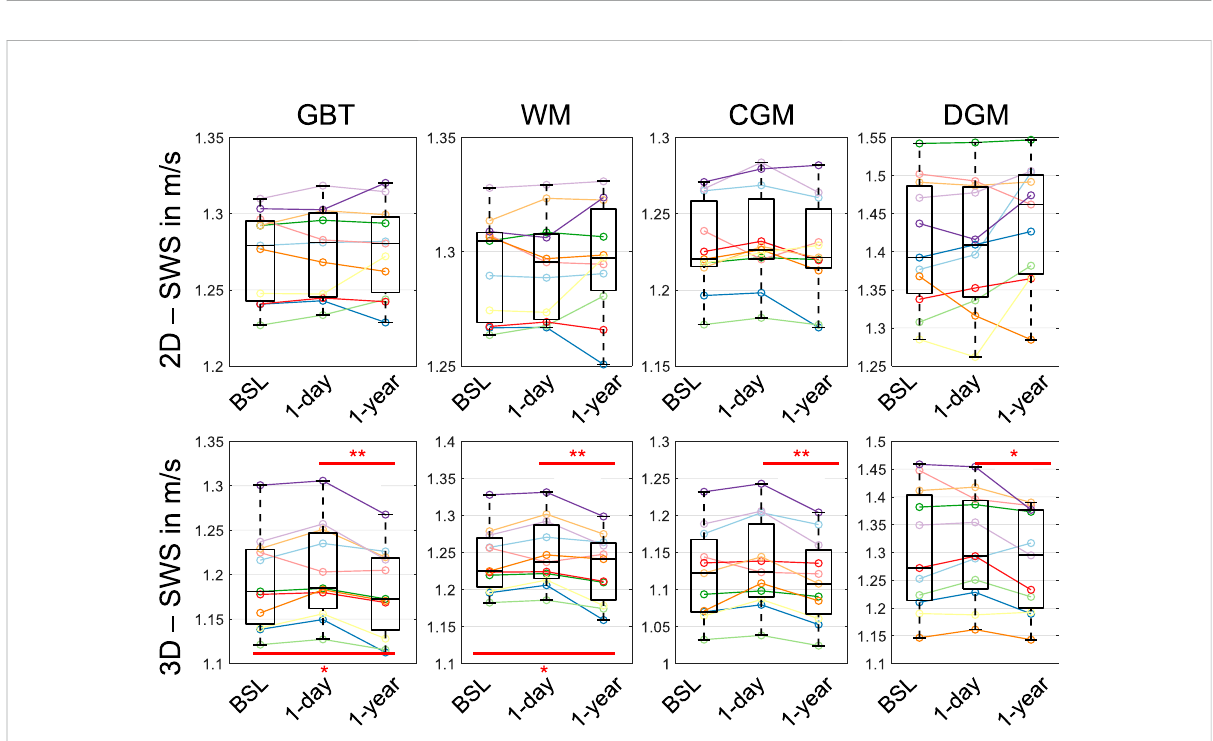
FIGURE 6 Group-averagedSWSvaluesfor2D(top)and3Dprocessing(bottom)inglobalbraintissue(GBT),whitematter(WM),corticalgraymatter(CGM), and deep gray matter (DGM). Averages were derived from eleven volunteers examined at baseline (BSL), 1 day later (1-day), and after 1 year (1-year). Signi fi cance levels, indicated by asterisks, were determined from paired t-tests with Holm-Bonferroni correction between BSL and 1-year as well as 1-day and 1-year.